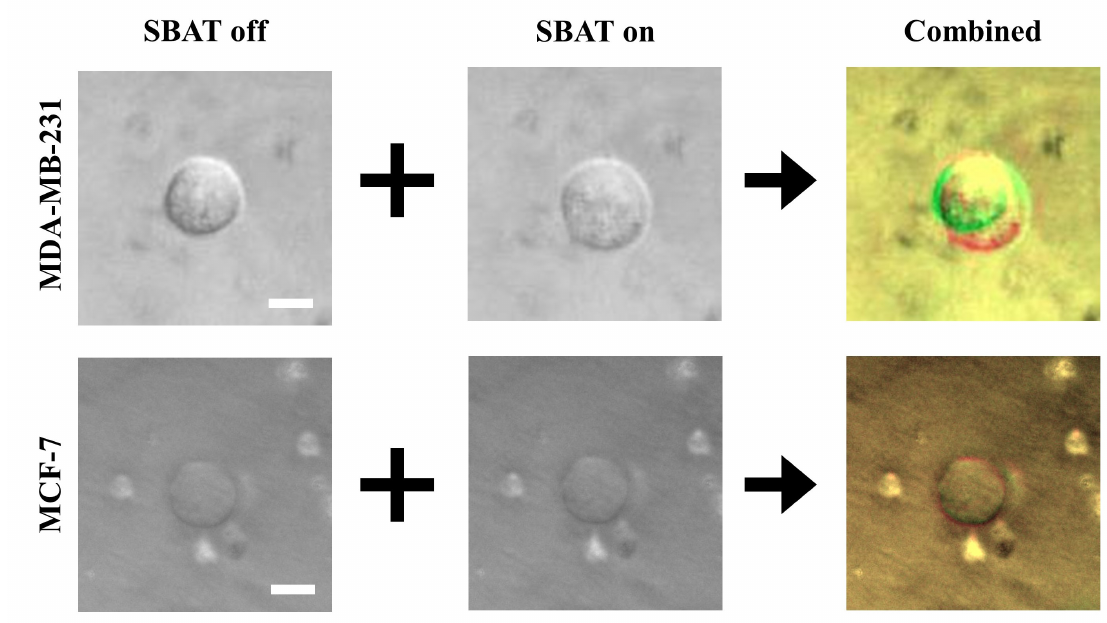
Figure 4. A comparison of the original photomicrographs with the preprocessed images. The first and second rows present preprocessing results of MDA-MB-231 and MCF-7, respectively. On the original images, the deformation is not always as significant as distinguishable with the naked eye. The preprocessing makes the deformation more distinctive than the original images. Additionally, the photomicrographs can include noises. On the combined images, only cell boundaries are emphasized by red and green colors, and noises have similar tones to the backgrounds. This point will provide robustness to the quality of photomicrographs. Scale bars indicate 10 µ m.